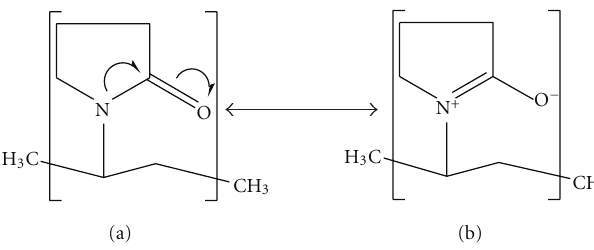
Figure 2: Schematic of the resonance structures of PVP molecule.